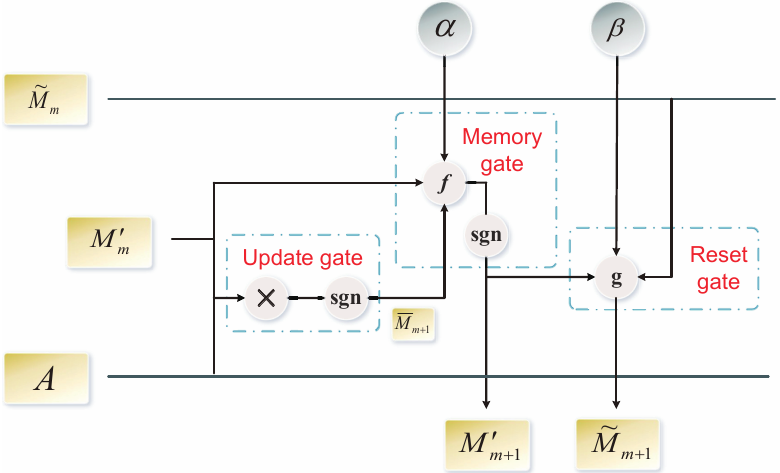
Figure 6. Gating mechanism in the proposed SN-GGAT. It includes update gate, memory gate, and reset